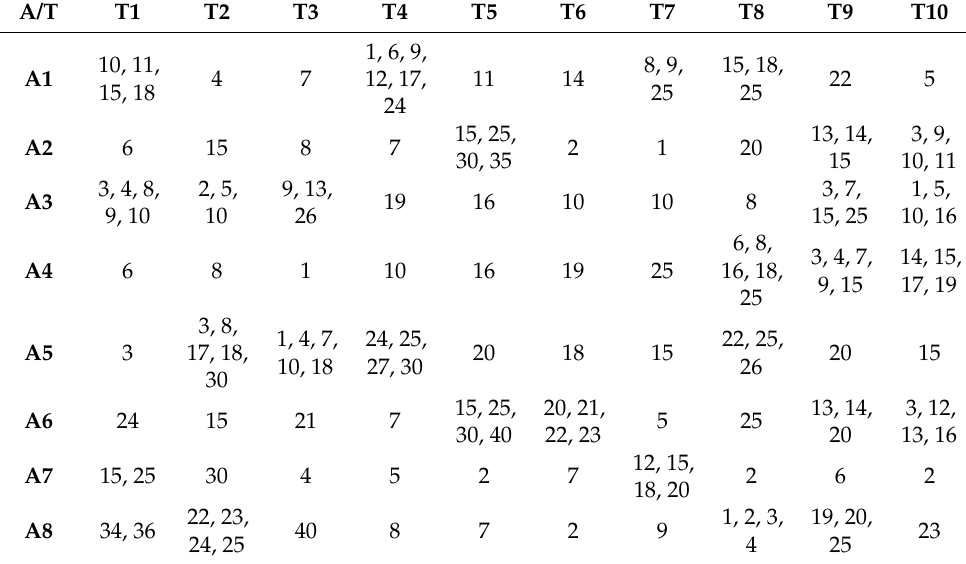
Table 3. Efficiency